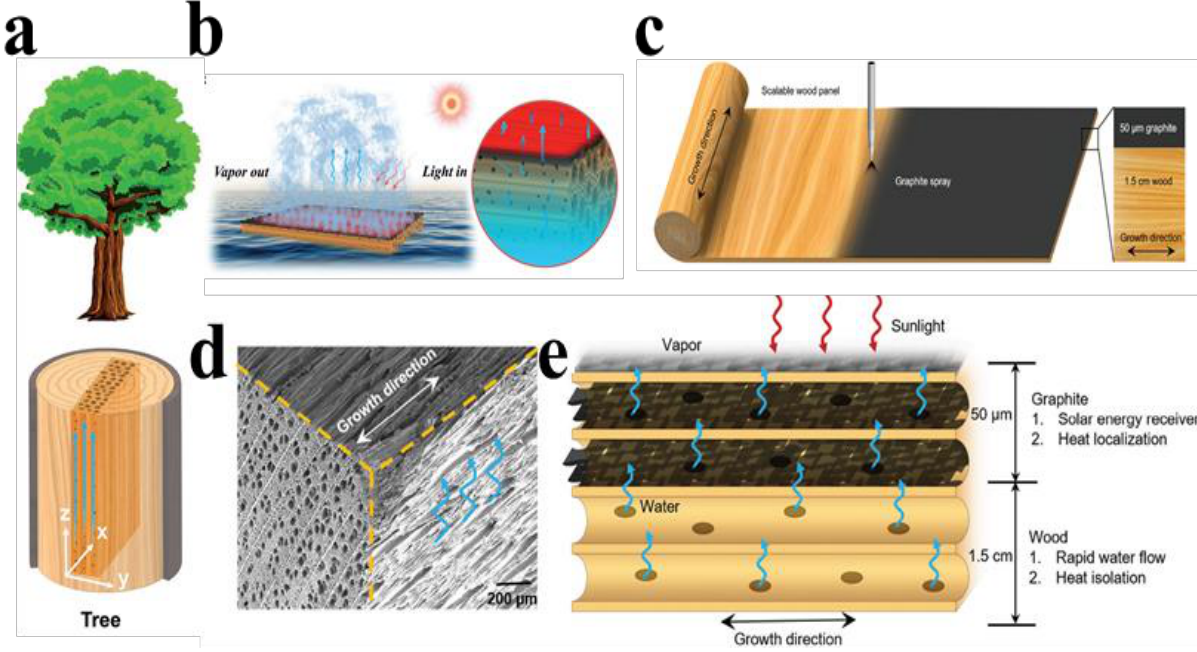
Figure 8: Thermal management of natural wood: (a) graphical illustration of the natural tree; (b) longitudinal wood blocks; (c) surface carbonization [88]; (d) manufacturing process; (e) SEM image of mesoporous wood; (f) the solar steam generation mechanism [104]